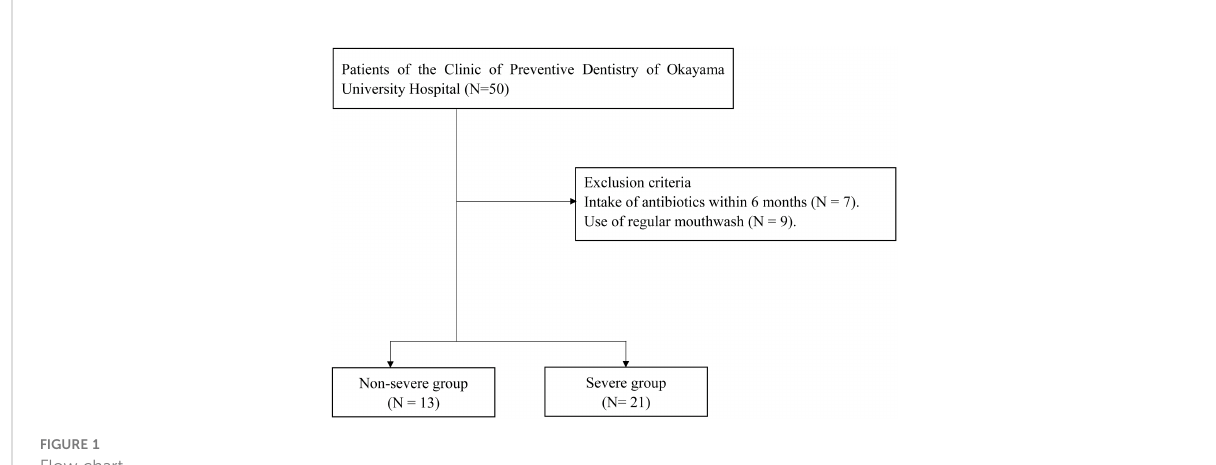
FIGURE 1 Flow chart.